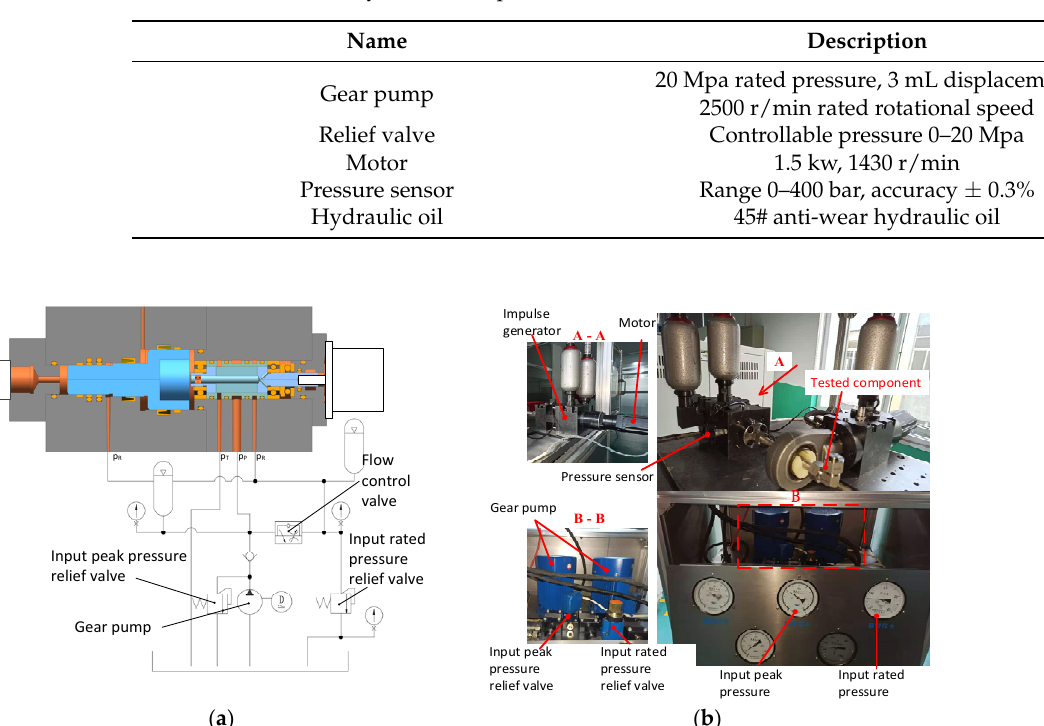
Figure 9. Test rig of the new hydraulic high-pressure impulse generator. ( a ) Schematic of the hydraulic system for the test rig. ( b ) An overview of the test rig. Table 3. Details of the hydraulic components.